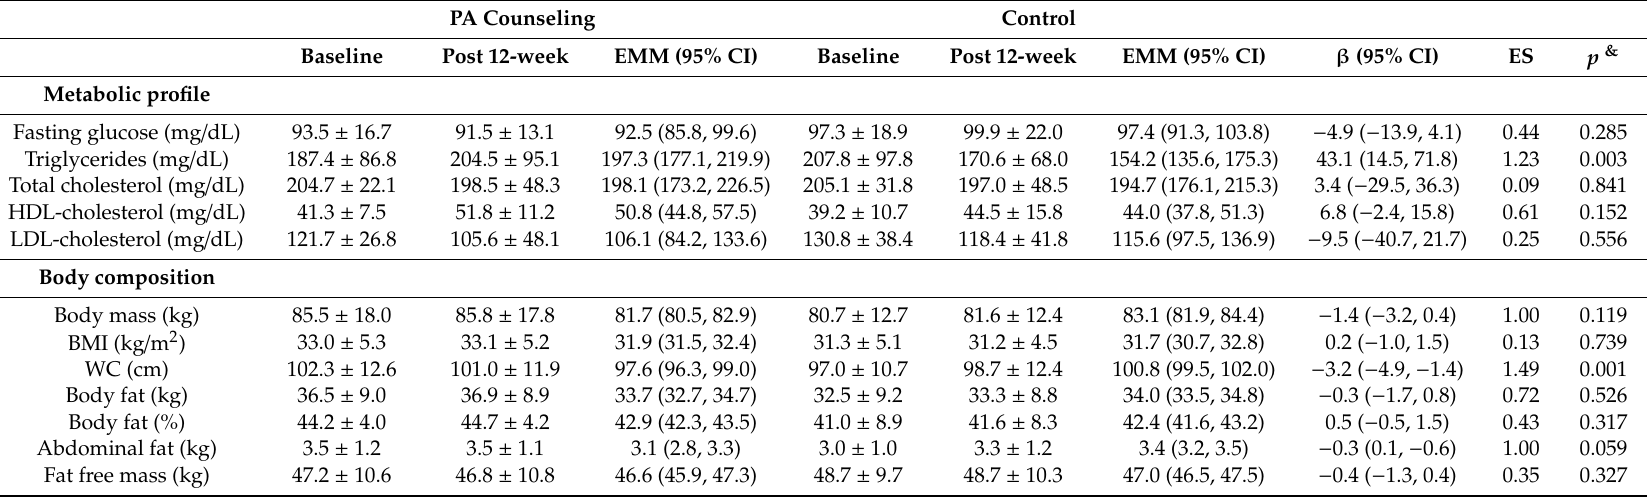
Data are expressed as mean ± standard deviation, estimated marginal means (EMM), parameter estimates ( β ), and 95% confidence interval (95% CI). BMI = body mass index; WC = waist circumference. Cohen’s ds e ff ect size ( < 0.50, small; 0.50 to 0.79, medium; and ≥ 0.80, large). & P -value refers to generalized linear model with gamma distribution model adjusted by baseline values. Bold values indicate significance at p <